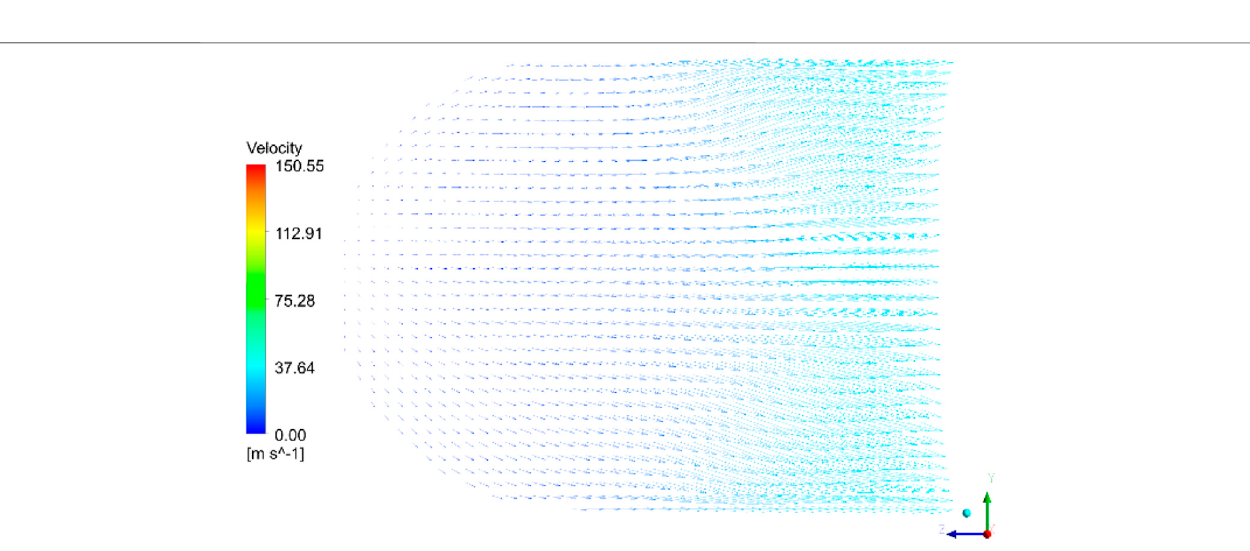
FIGURE 11 | The velocity vector fi eld of the cross section at the top of the drying